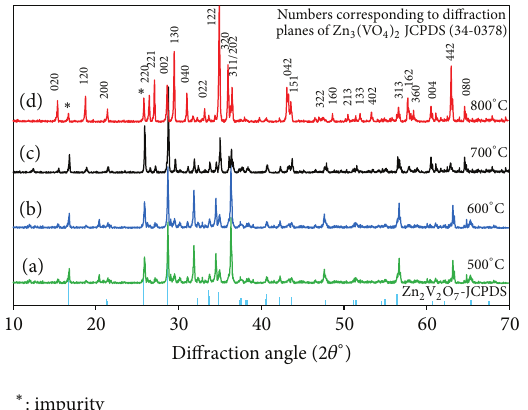
Figure 1: XRD patterns of series of Zn 3 V 2 O 8 phosphor prepared at different temperatures.